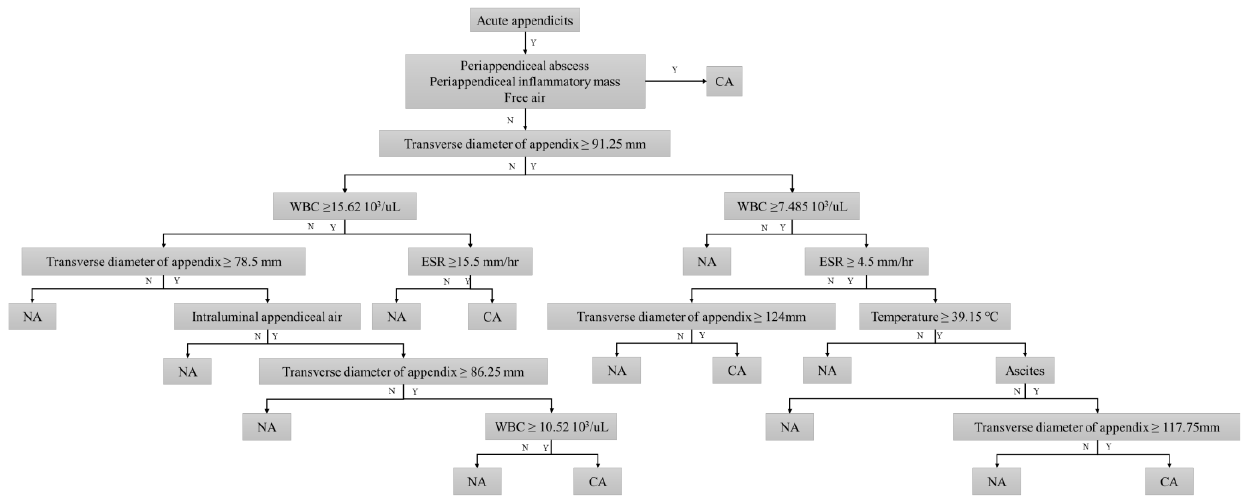
Figure 2. Proposed diagnostic algorithm based on the decision tree to predict complicated appendicitis.